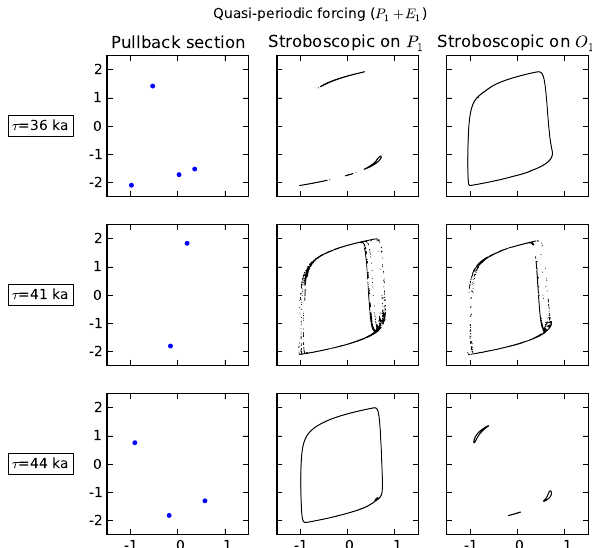
Fig. 8. As Fig. 6 but with a 2-period forcing: F(t) = γ( sin ( 2 π/P 1 t + φ P 1 ) + sin ( 2 π/O 1 t + φ O 2 )) (see text for values). Tongues originating from frequency-locking on individual periods merge and give rise to strange non-chaotic attractors. Orange dots correspond to the cases shown in Fig.